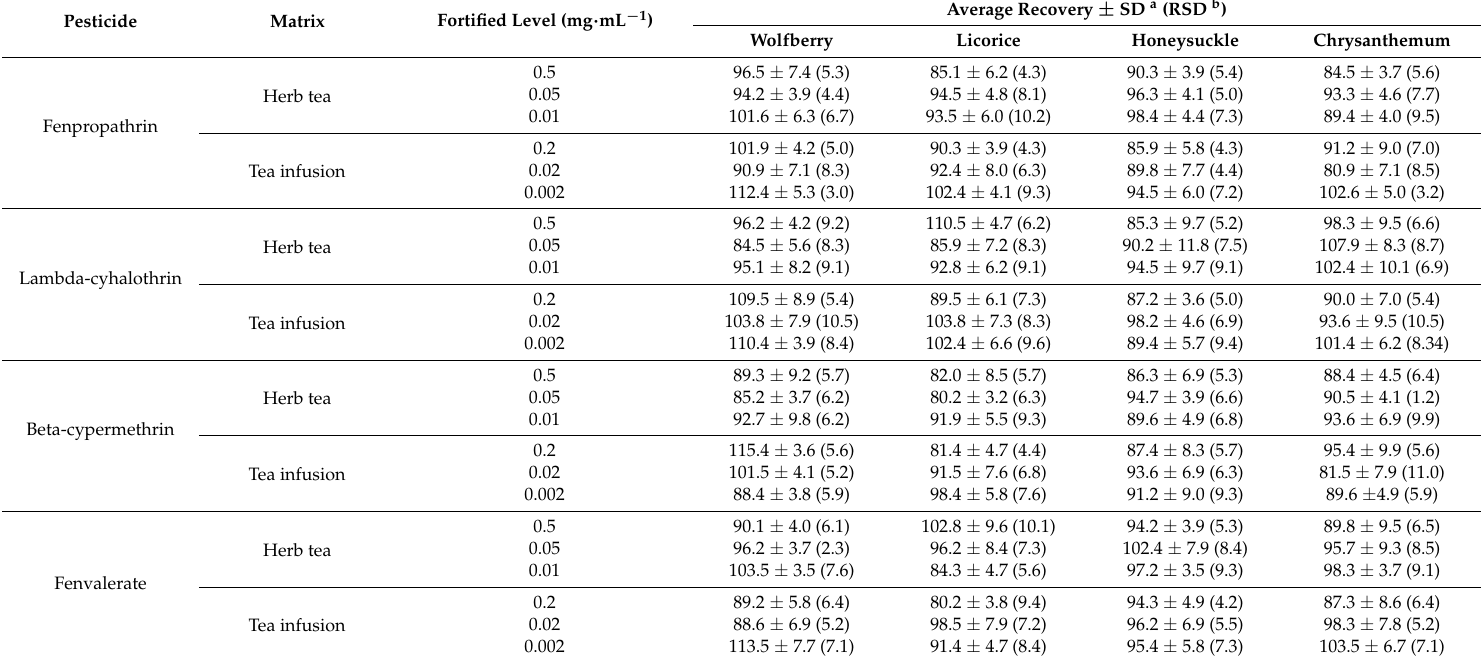
Table 1. Analytical recoveries of the four pyrethroids from different herbal tea and infusion samples ( n =